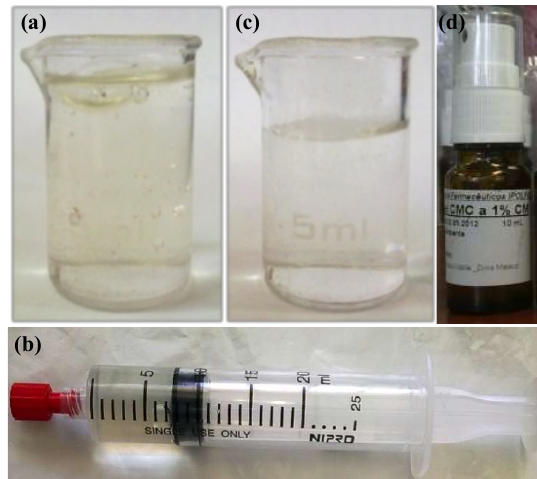
Figure 1. General appearance of the hydrogel formulations: ( a ) Morphine Hydrochloride-containing semi-solid gel (F1-MH) after preparation; ( b ) F1-MH gel packaged in a sterile polypropylene unidose syringe with a luer-lock tip; ( c ) Morphine Hydrochloride-containing fluid gel (F2-MH) after preparation; ( d ) F2-MH gel packaged in a 10 mL amber Type II glass flask with a spray actuator .